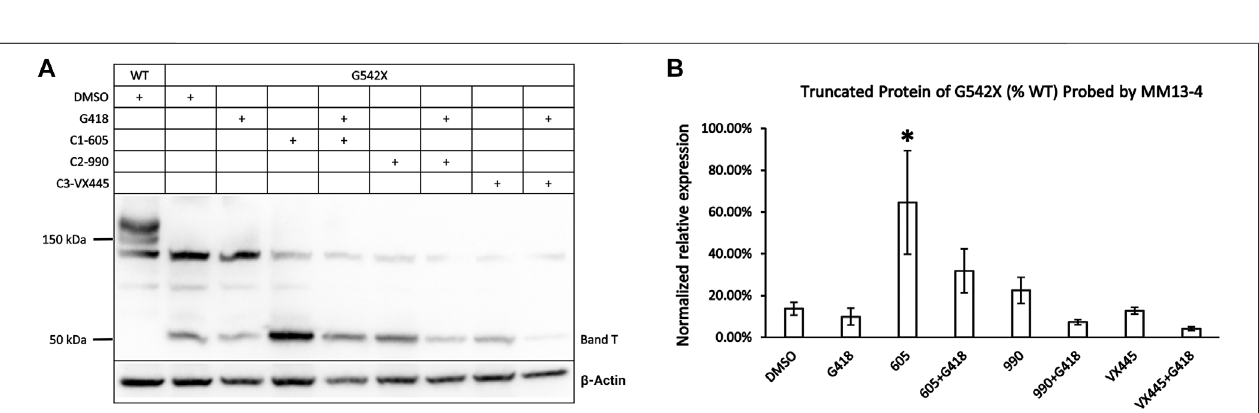
FIGURE 3 | Effects of CFTR correctors on the expression of the C-terminus truncated protein of G542X-CFTR using mouse monoclonal anti-CFTR N-terminal antibodyMM13-4. (A) Effectsoftype1(605),2(990),and 3(VX-445) CFTR correctorswithorwithouttheread-through reagentG418onG542X-CFTR expression. The gel was probed with anti-CFTR N-terminal antibody MM13-4. (B) Quanti fi cation of the effects ofCFTR correctors on the expression of the C-terminus truncated protein of G542X-CFTR. The band C of WT-CFTR in the same gel was used for normalization. Data are represented as mean ± SEM. The asterisks indicated that the expression of band T in G542X-CFTR is signi fi cantly higher when compared with DMSO (N = 3, ANOVA followed by Dunnett ’ s test). * p < 0.05.